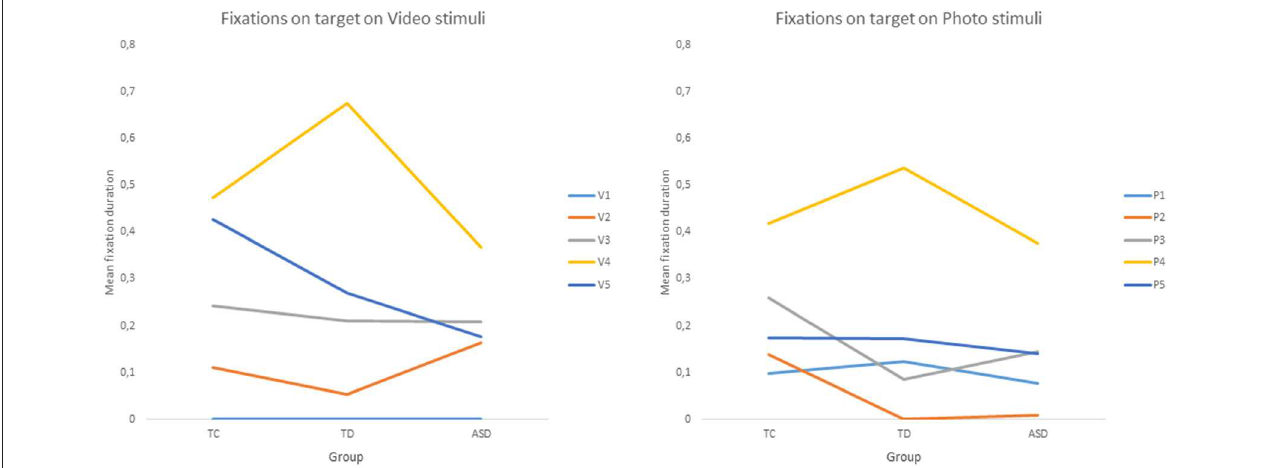
FIGURE 4 | Mean of relative fixation duration on target by group and stimuli. Legend : V1, V2, V3, V4, V5 = Video stimuli; P1, P2, P3, P4, P5 = Photo